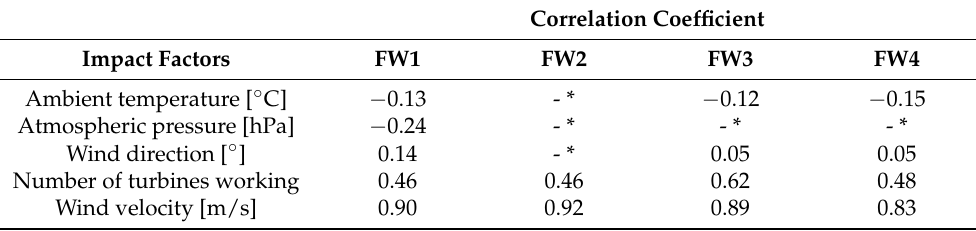
Table 2. Pearson correlation coefficient, additional factors/power plant